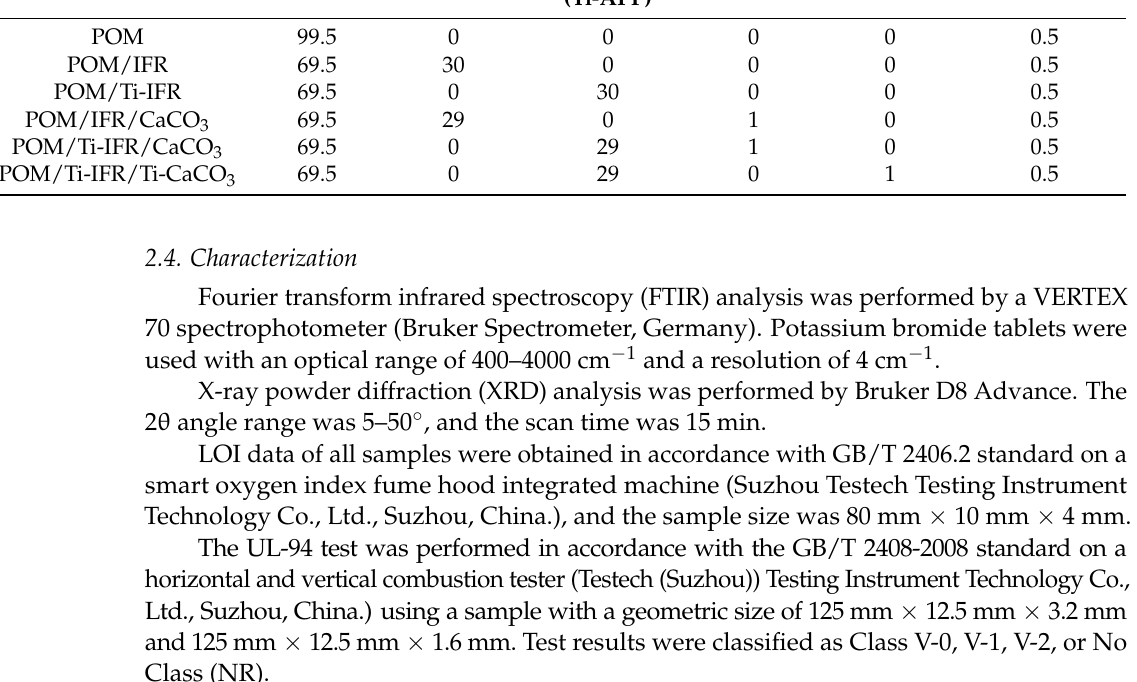
Figure 4. Schematic diagram of the preparation process of modified APP and CaCO 3 .